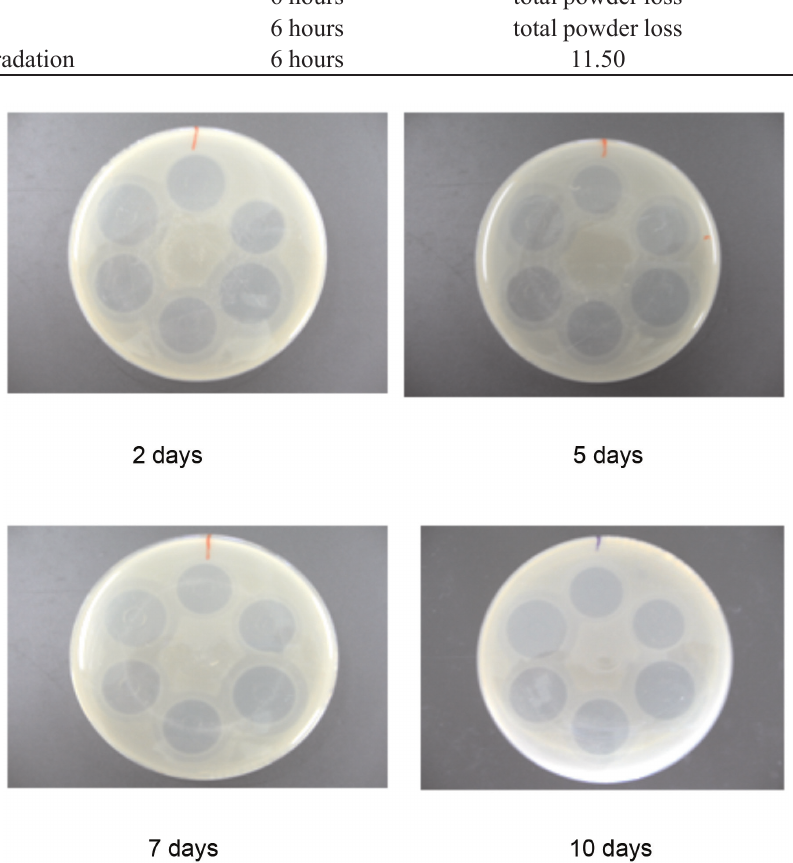
FIGURE 8 - Zone diameters for the azithromycin under solar light